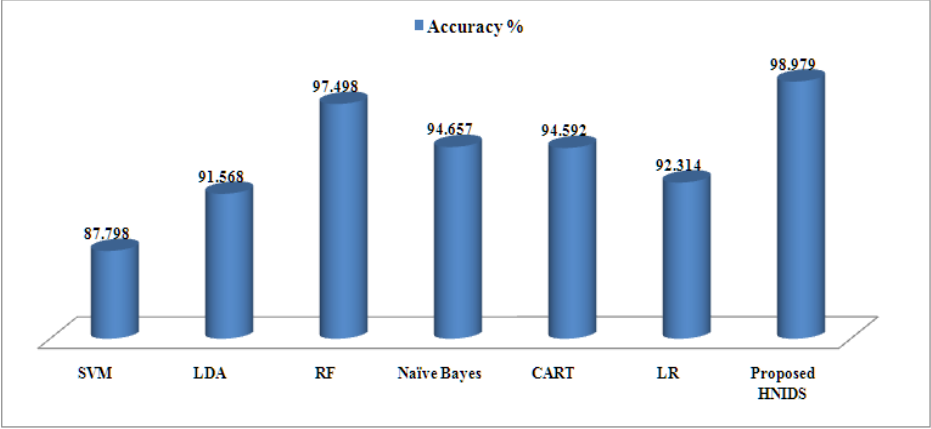
Figure 4. Accuracy % for proposed HNIDS model for BCC.